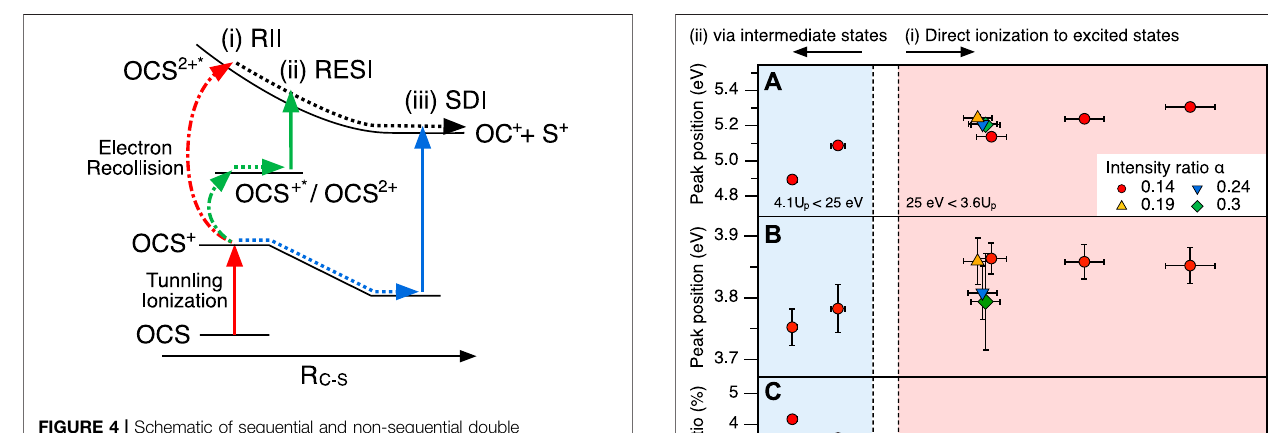
FIGURE 4 | Schematic of sequential and non-sequential double ionization and dissociation processes of OCS along the C-S bond stretching coordinate. Three possible pathways for population to the excited states of OCS 2+ (OCS 2+ *); (i) Recollision impact ionization (RII) leading to direct ionization to OCS 2+ * by electron recollision, (ii) recollisional excitation with subsequent ionization (RESI) causing indirect population to OCS 2+ * via intermediate states (OCS + * or OCS 2+ ), and (iii) sequential double ionization (SDI) leading to ionization from OCS + , involving bond stretching. Due to the different bond stretching in the intermediate states and the shape of the PES of OCS 2+ *, the observed KERs appear in the order (i) > (ii) > (iii). Vertical solid arrows indicate ionization or excitation by laser fi elds. Curved dash-dotted arrows show ionization or excitation by electron recollision, dotted arrows represent bond stretching.